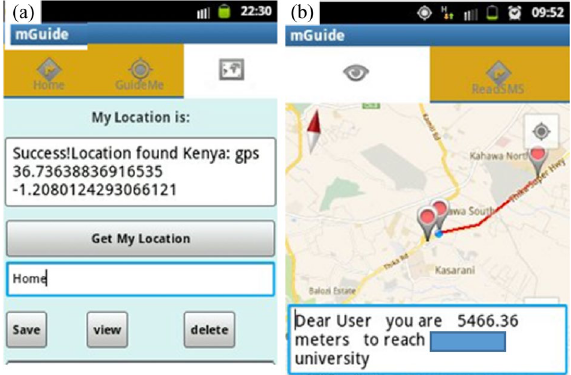
Fig. 3 Screenshots of the running “mGuide” application. a Obtaining the GPS coordinates and b Real-time navigation to the set